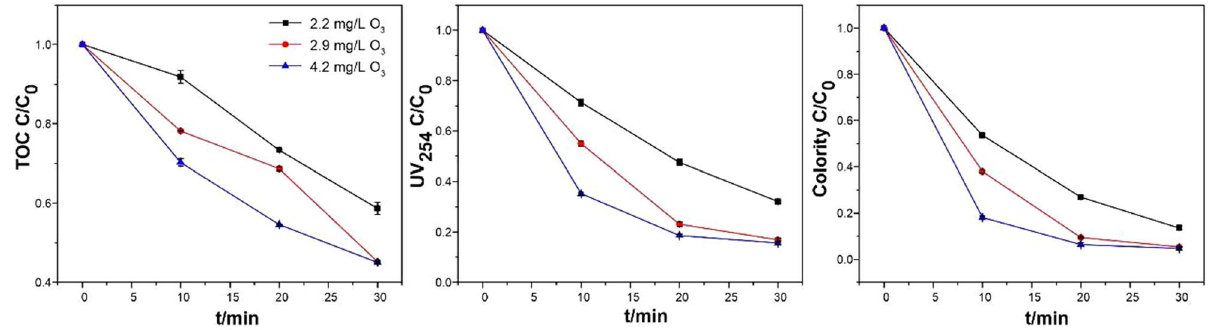
Figure 4. Effect of ozone dosage in an aqueous solution on catalytic ozonation by Cu/Ce–Al 2 O 3 (experimental conditions: pH